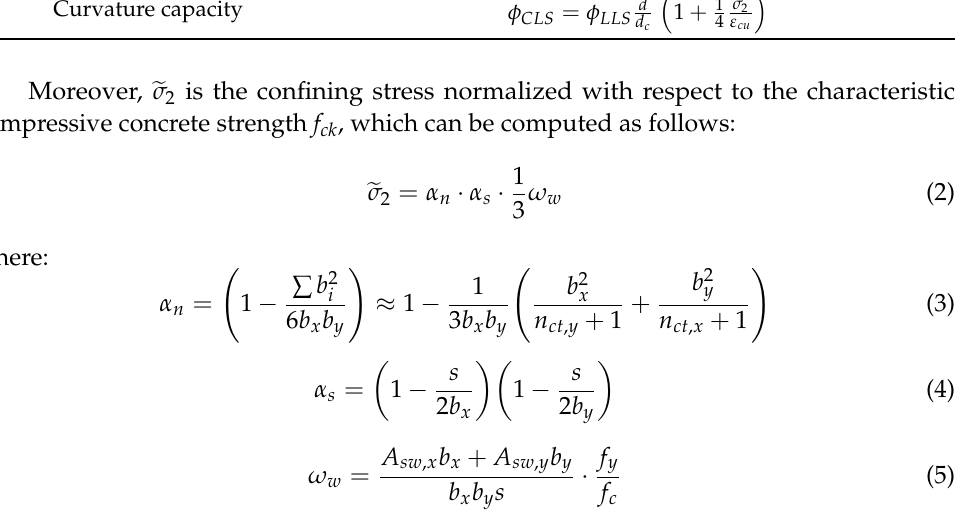
Figure 3. Cross-section with geometric parameters: 𝑑 is the section depth, 𝑏 is the section width,